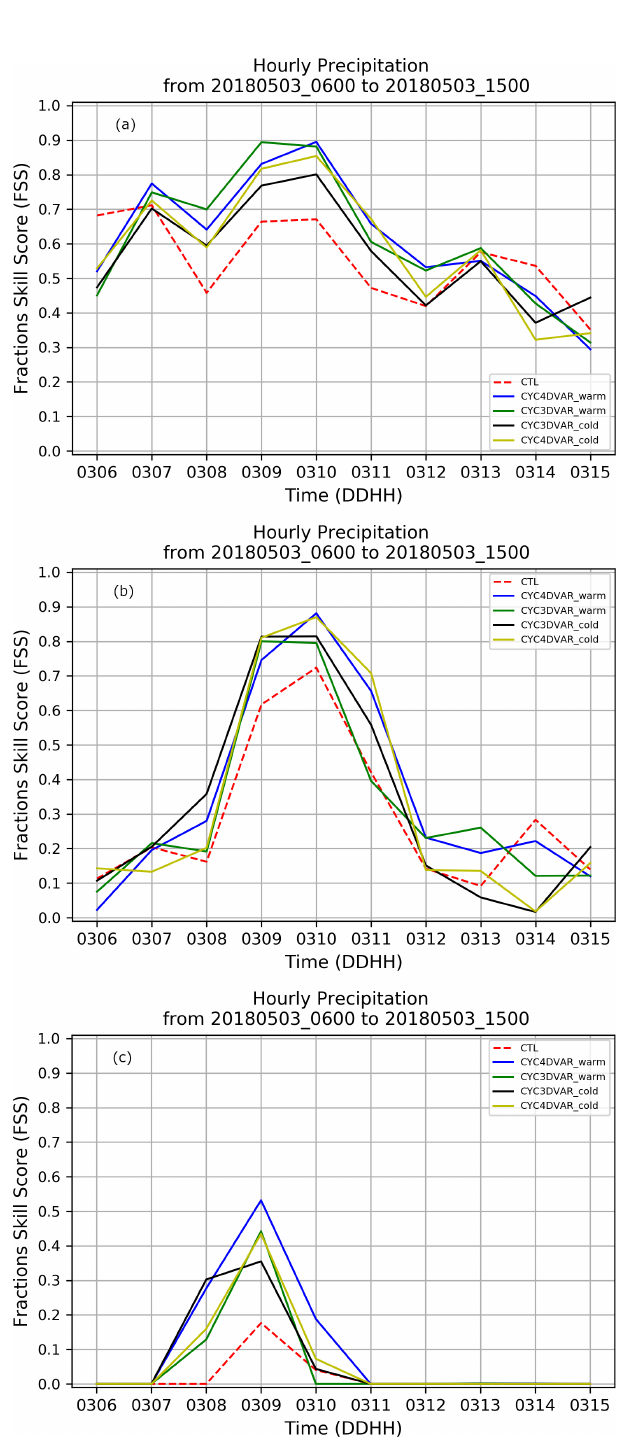
Figure 7. Evolution of FSS calculated in the LA region consider- ing the hourly accumulated precipitation for three threshold values: 1mmh − 1 (a) , 3mmh − 1 (b) and 8mmh − 1 (c) . The dashed red line represents the CTL, the blue line CYC4DVAR_warm, the green line CYC3DVAR_warm, the black line CYC3DVAR_cold, and the yel- low line